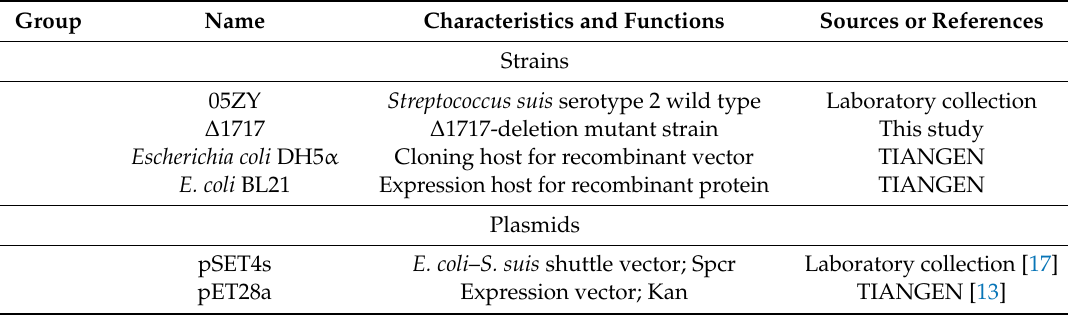
Table 1. Summary of the bacterial strains and plasmids used in this